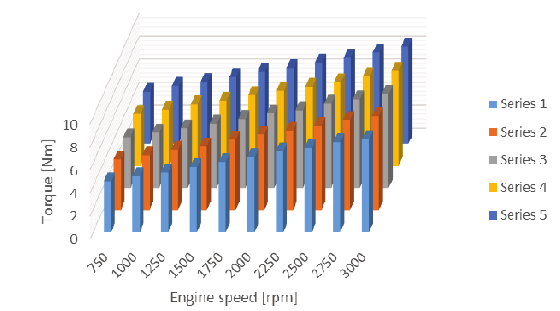
Fig. 4. Course of torque for the five series measuring – oil temperature 50°C